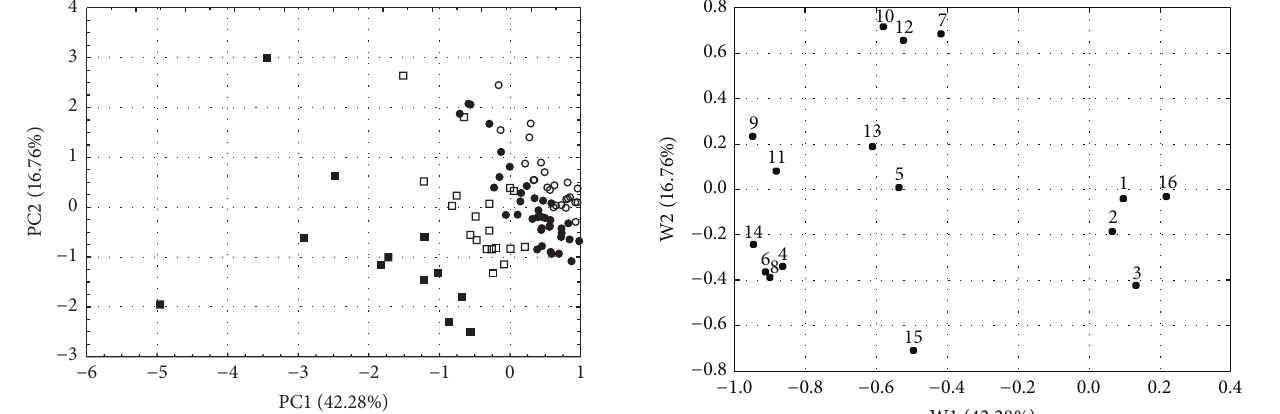
Figure 3: PCA loadings plot illustrating the impact of fourteen raw variables on the scattering of ninety-seven patients under antidepressant therapy. The Arabic digits denote the raw variables as follows: 1: patients age, 2: multiplicity of hospitalization, 3: period of hospitalization, 4: initial cortisol level, 5: final cortisol level, 6: the highest cortisol concentration, 7: the lowest cortisol concentration, 8: difference between the highest and lowest cortisol concentration, 9: mean concentration, 10: median determined during the whole period of hospitalization, 11: mean level of hormone during the 30% of the hospitalization period, 12: mean level of hormone during the 60% of the hospitalization period, 13: mean level of hormone during the 90% of the hospitalization period, 14: standard deviation of the mean concentration, 15: relative standard deviation of the mean concentration, and 16: